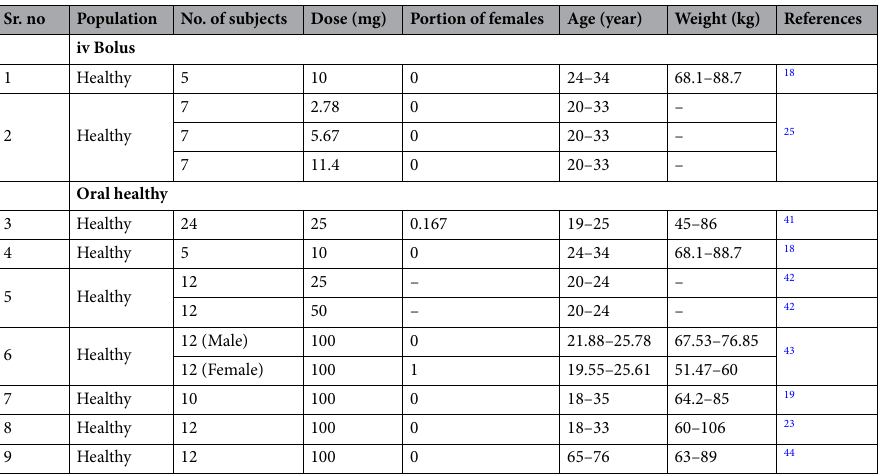
Table 2. Population data used for development and evaluation of the captopril PBPK model in healthy adults.